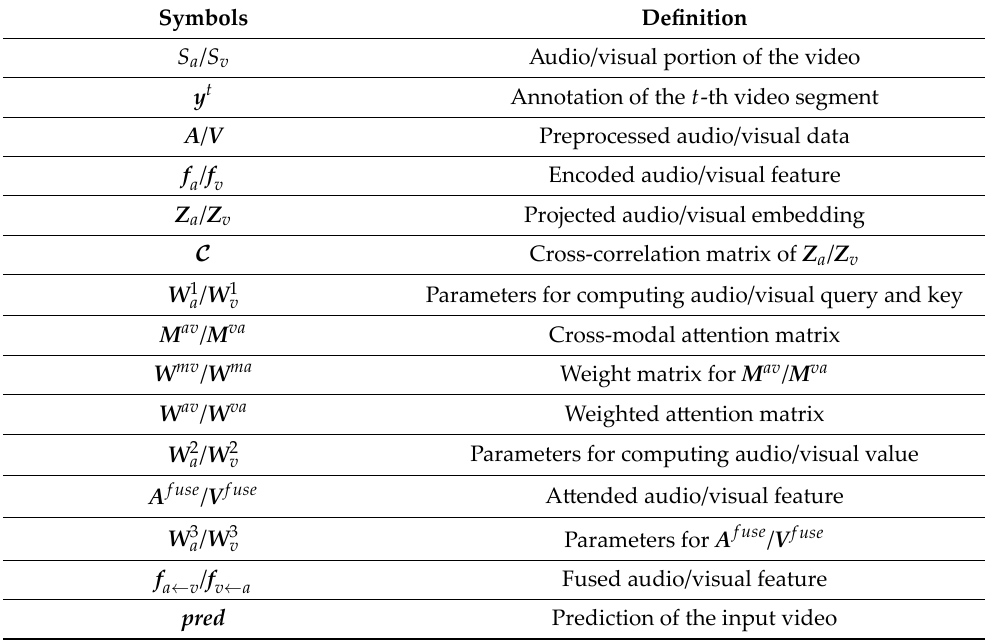
Table 1. Main symbols used throughout the